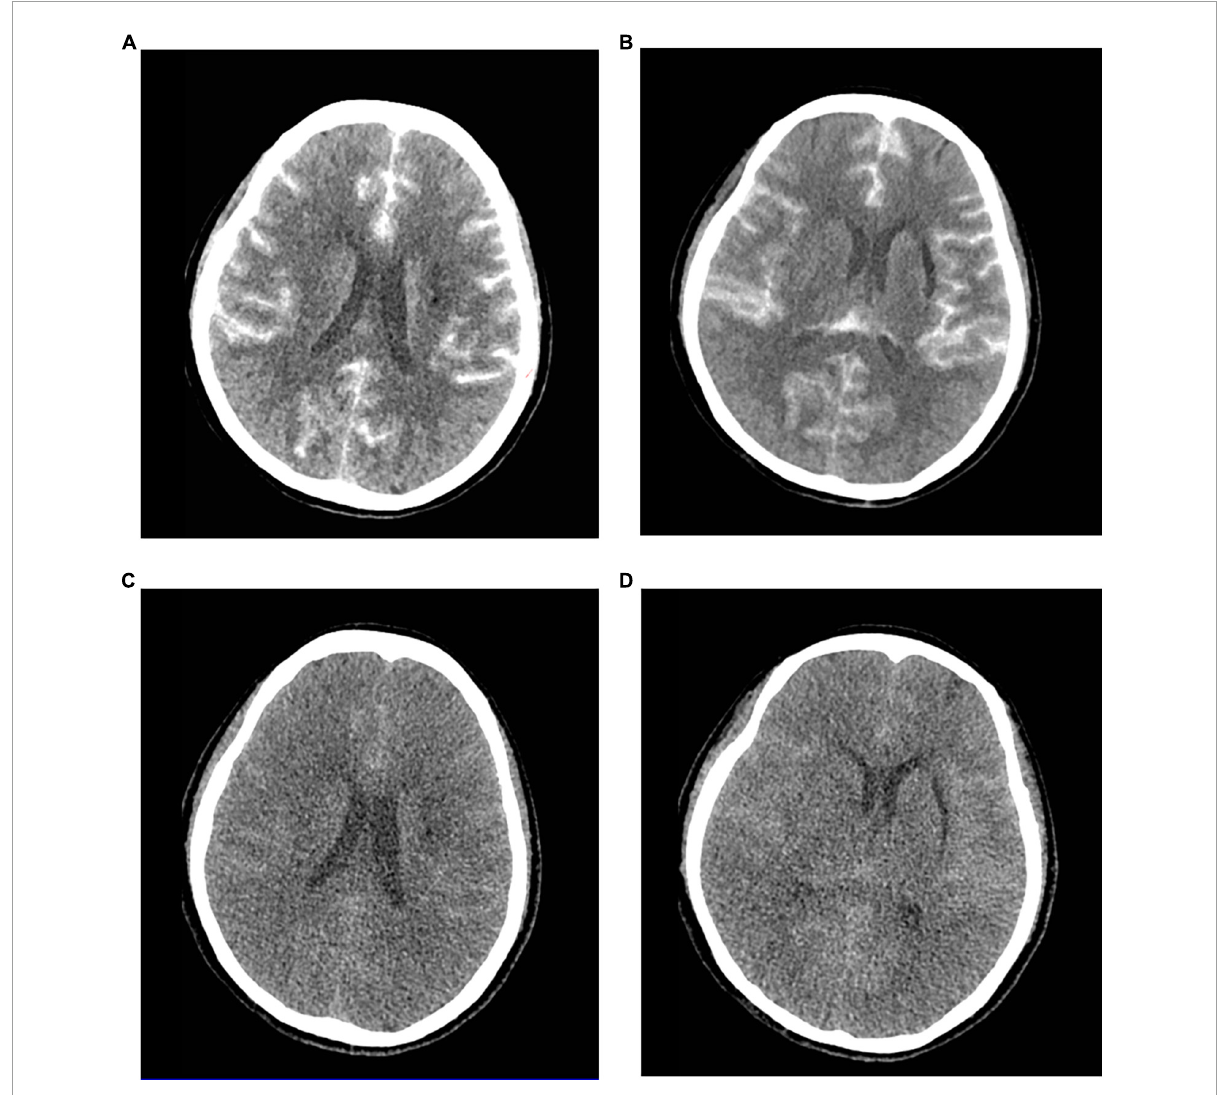
FIGURE1 Contrast-induced encephalopathy in brain computed tomography (CT) scans. (A,B) Emergency brain CT 5 h after the procedure showed diffuse contrast enhancement in the brain parenchyma and subarachnoid space with mild global brain edema and the softening foci in the left basal ganglia-insular area. (C,D) Brain CT 2 days after the procedure indicated diffuse enhancement disappeared, and the brain parenchyma was diffusely swollen and the lateral ventricle was slightly more compressed.